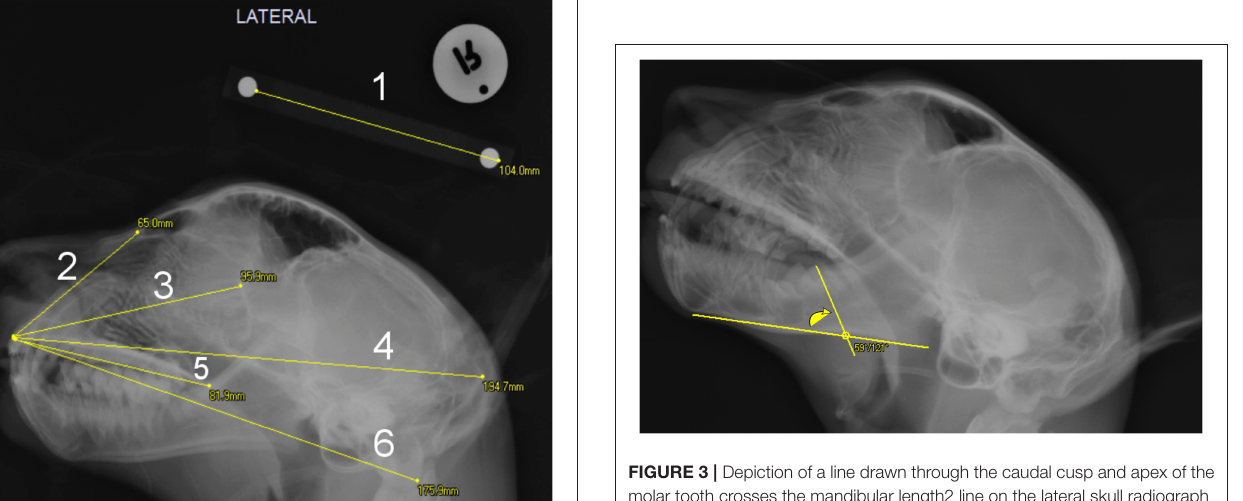
FIGURE 2 | Extent of measurements on the mandible taken from the lateral skull radiographs: 1- Mandibular length1; 2- Mandibular length2. On this cropped image the 100mm scale bar is not visible.